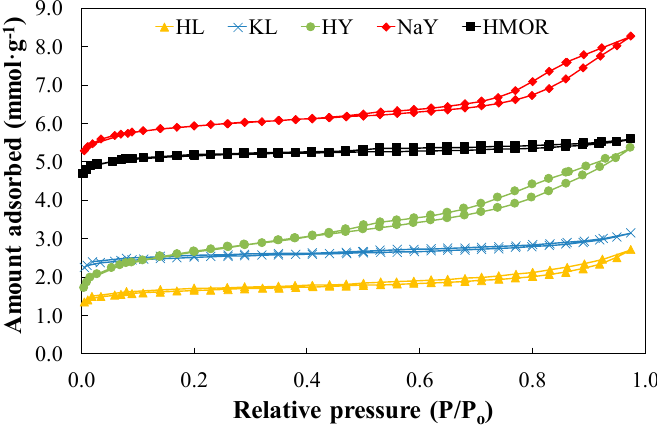
Figure 1. N 2 adsorption–desorption isotherms of the catalysts at − 196 °C.